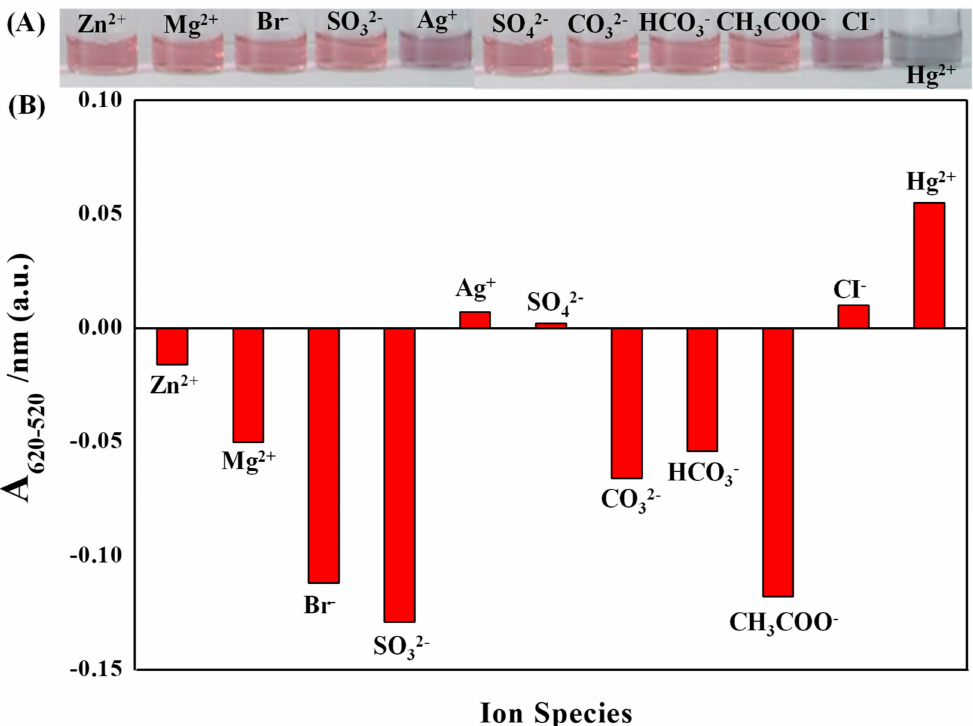
Figure 4. The role of Hg 2 + : ( A ) photographs and ( B ) bar response comparison diagram results of probe applied in detecting 50 µ M creatinine under same identical condition, which contains PEG (0.67